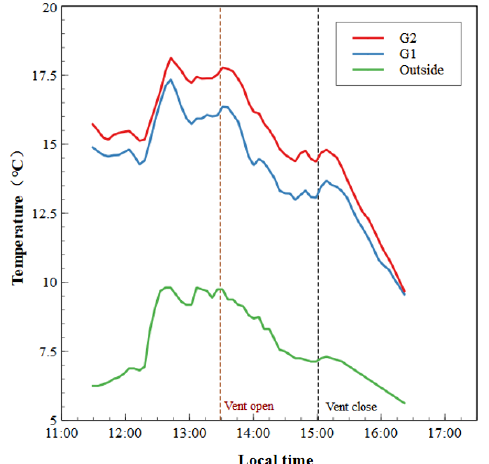
Figure 4. G1 and G2 average temperature data.